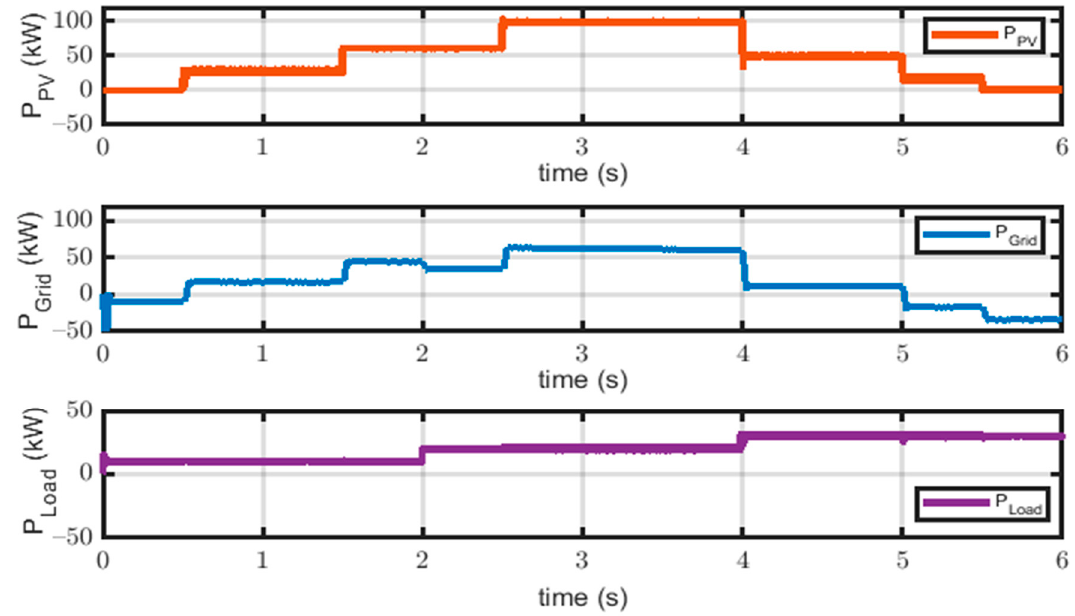
Figure 13. Power flow in Grid-Tied DC PV microgrid with different load demands.